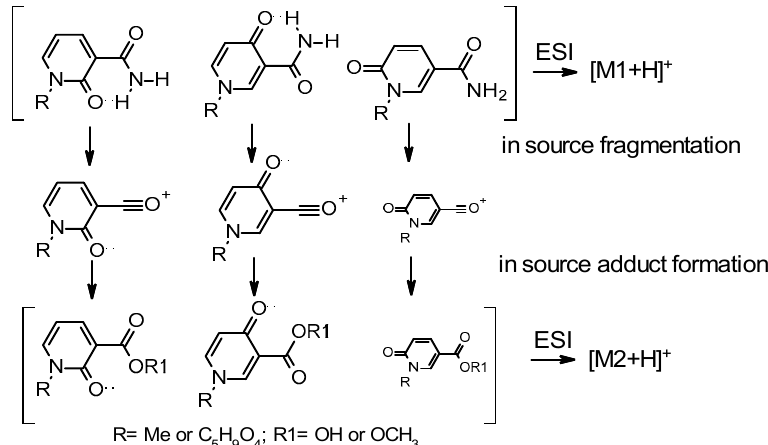
Figure 2. Pyridone carboxamides, their ESI-induced fragment, and the subsequent in source gen- erated adduct. The contribution of in-source fragmentation of the N-Me-6PY is thought to be mini- mal.